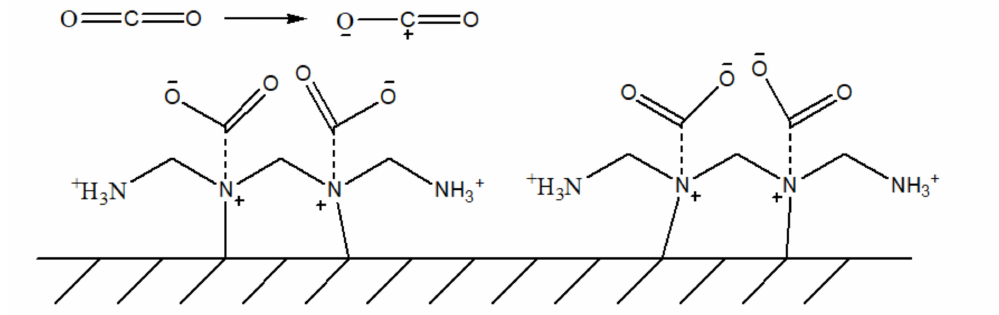
Figure 7. Proposed reaction mechanism between TETA and CO 2 at the surface of mesoporous